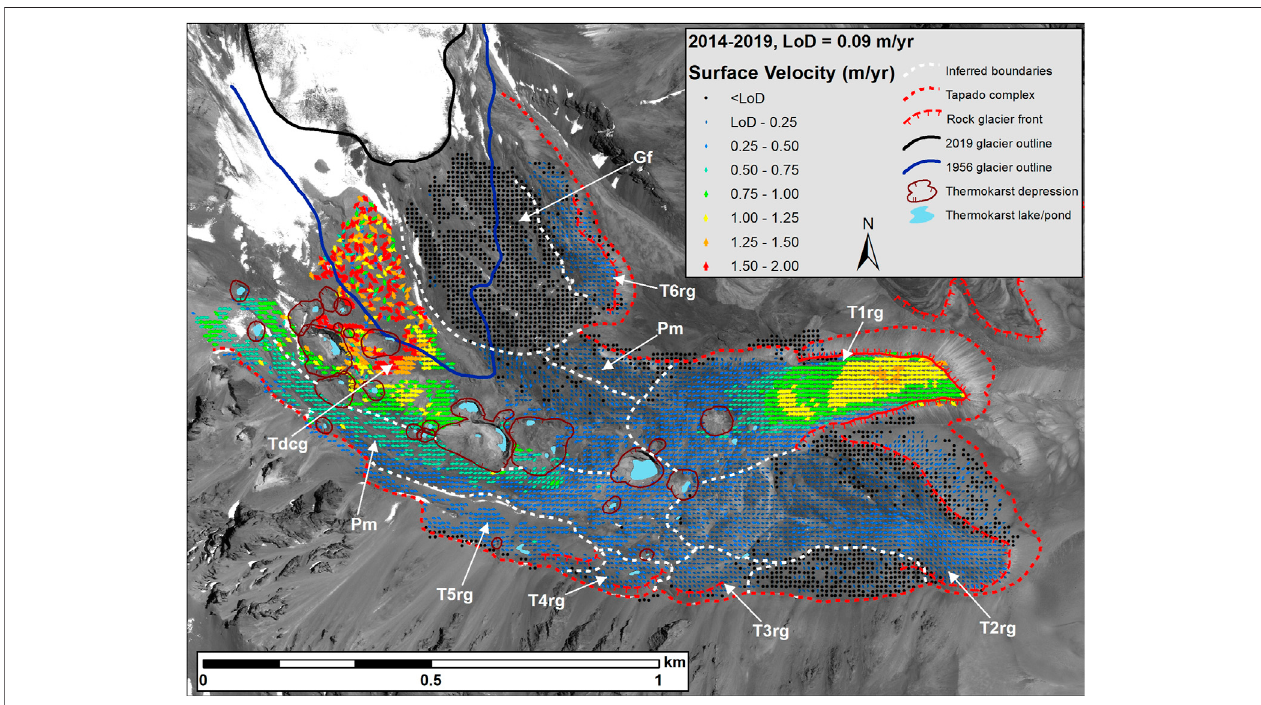
FIGURE 9 | Geomorphological interpretation of the Tapado complex base on recent surface kinematics and multitemporal analysis. Gf: glacier fore fi eld, Tdgc: Tapado debris-covered glacier, Pm: Push moraine, T1 – 6rg: Tapado rock glacier units. The background image corresponds to an orthorecti fi ed Pléiades image from January 2019. © CNES (2018), and Airbus DS (2018), all rights reserved.